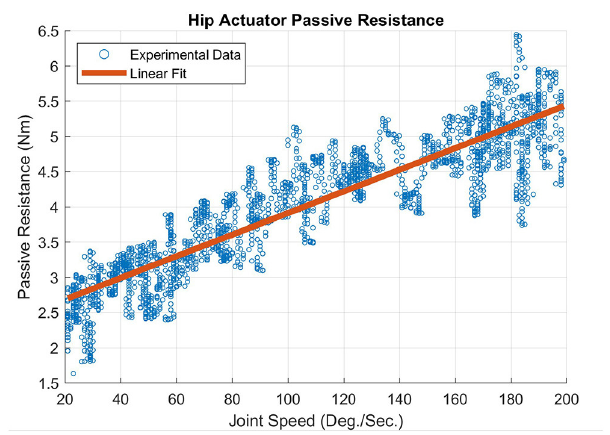
FIGURE 2 | Passive resistance of the hip joint